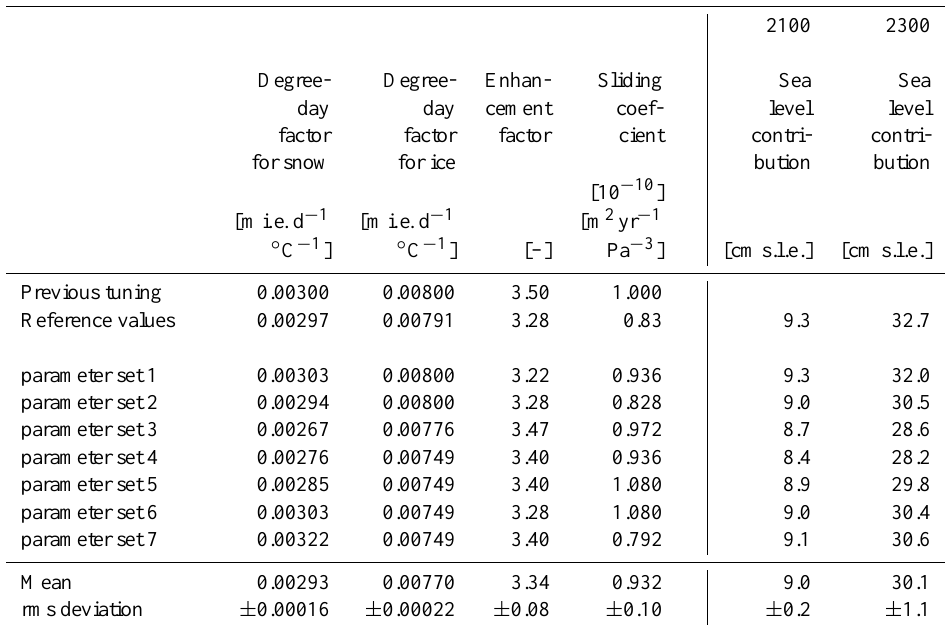
Table 1. Sensitivity of future sea-level change to main model parameters. Values from a previous tuning are indicated together with the reference values for this study. Mean and rms values are given for the ensemble projections forced with CanESM2/RCP4.5. Positive degree day factors are given in ice equivalent